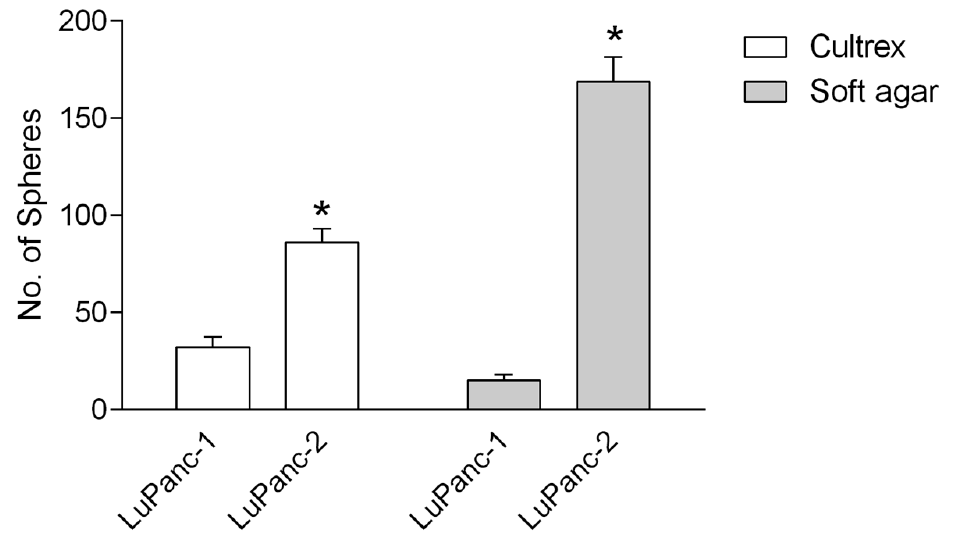
Figure 4. Tumor sphere assay of LuPanc-1 and LuPanc-2 cells. Both cell lines formed spheres in cultrex and soft agar. LuPanc-2 cells formed significantly more spheres compared to LuPanc-1 cells under both conditions. Data are the mean ± SD of two biological replicates, each comprising three technical triplicates. The asterisks (*) indicate a significant difference ( p < 0.05, Student’s t